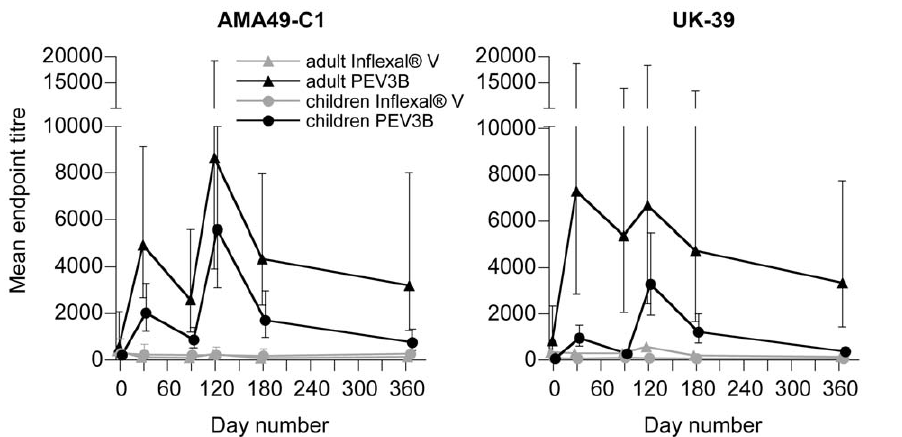
Figure 2. Development of anti-AMA49-C1 and anti-UK-39 IgG ELISA endpoint titres in adults and children immunized with PEV3B or Inflexal H V. Bars indicate 95% confidence intervals of the geometric mean (no bars are shown for adult Inflexal H V, n=2). Participants were immunized on days 0 and 90 (see arrows).